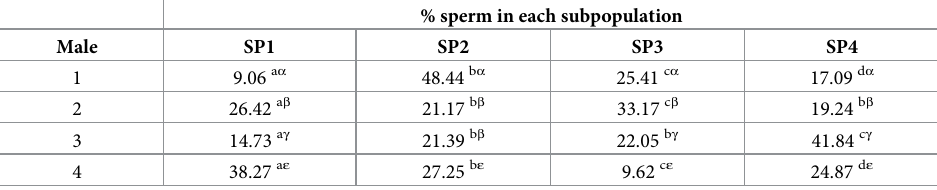
Each row indicates the percentage of spermatozoa in each sperm subpopulation. For characterization of each subpopulation see text, Table 5 and Fig 3. Total number of cells for each male: Male 1 = 2153, male 2 = 1089, male 3 = 1819, male 4 = 2859. a, b, c, d Superscript indicates differences within row regarding sperm subpopulation.